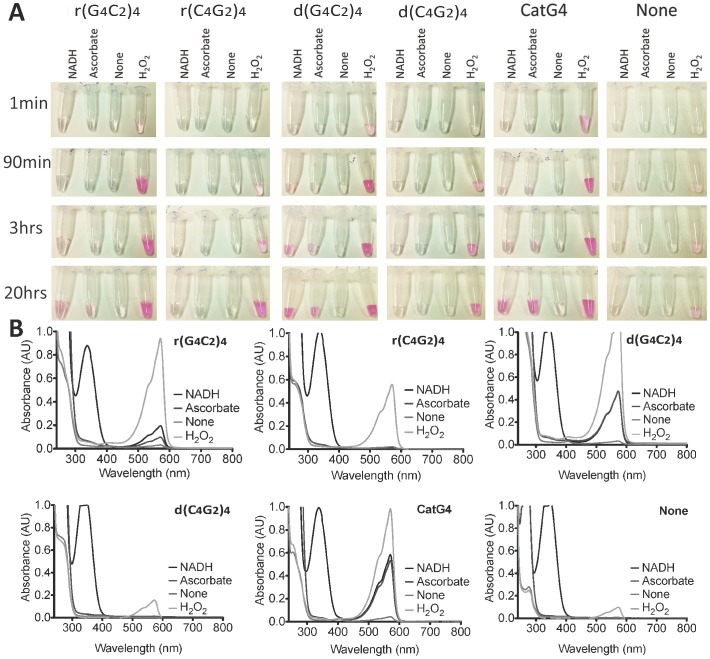

c9orf72 repeat DNA and RNA catalyze oxidase reactions with NADH and ascorbate.(A) A photographic record of the oxidase activity of different DNA/RNA solutions in the presence of heme. Amplex Red oxidation to resorufin produces an intense red color. Each solution containing DNA/RNA (10 µM) and heme (1 µM) was incubated with 1 mM Amplex Red in the presence of NADH or Ascorbate (1 mM), the absence of a reductant or hydrogen peroxide (0.1 mM). (B) UV/Vis spectra for samples from panel A at ∼24 hrs, showing characteristic spectra for resorufin (lmax ∼570 nm).